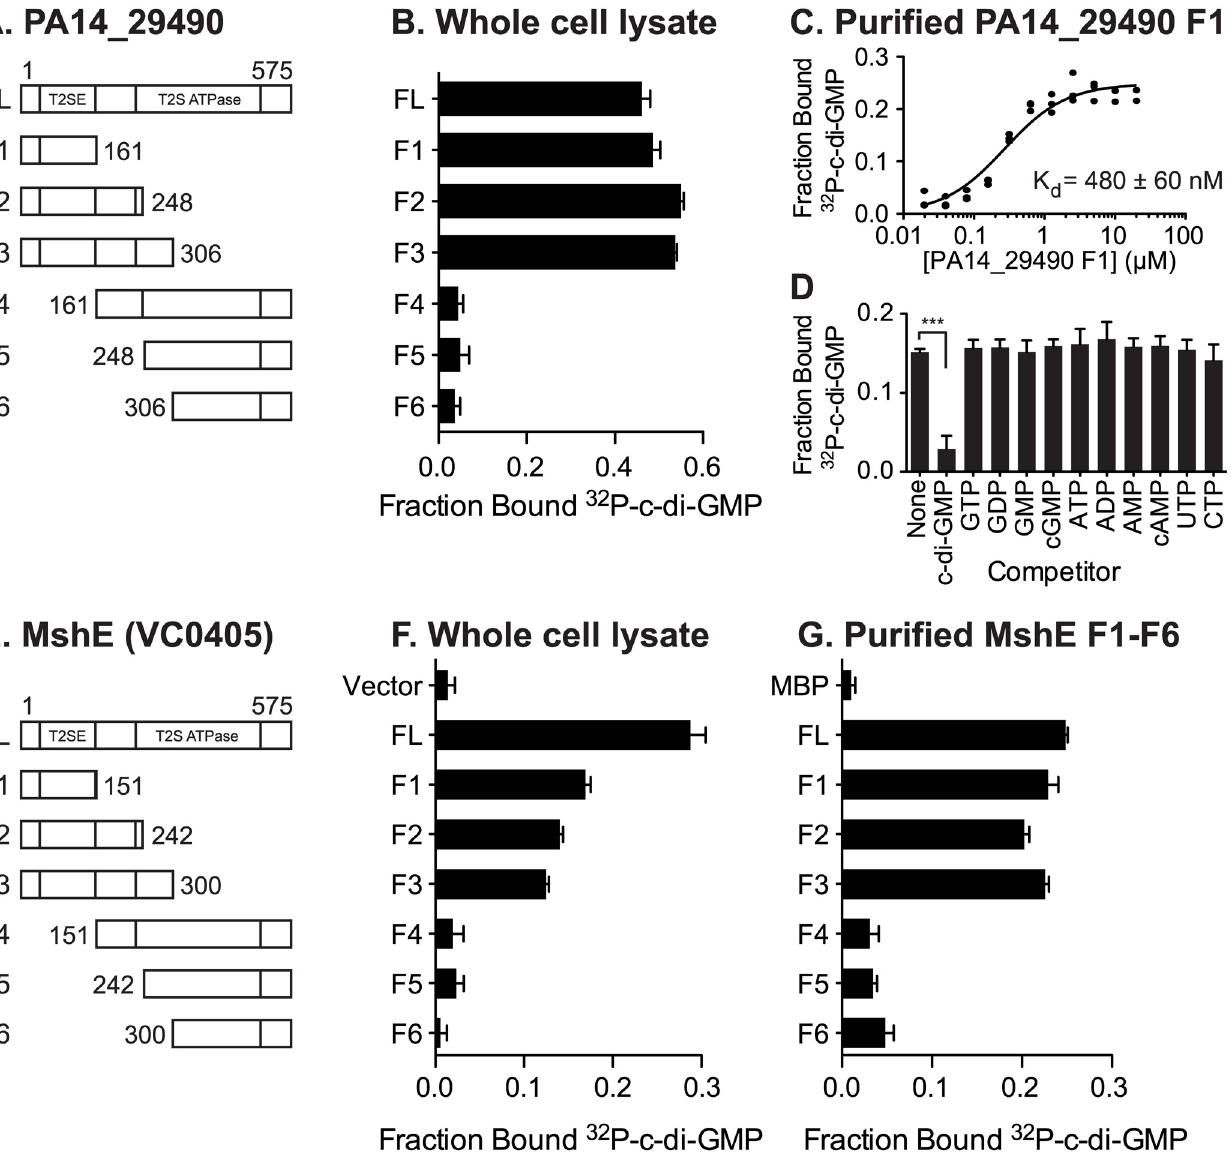
Fig 4. C-di-GMP binds MshE and PA14_29490 in the N-terminal T2SSE_N domain. Schematic of the truncations generated in (A) PA14_29490 and (E) MshE. C-di-GMP binding to E . coli whole cell lysates expressing each fragment of (B) PA14_29490 and (F) MshE. (C) Fraction bound 32 P-c-di-GMP to decreasing concentrations of purified PA14_29490 fragment 1. (D) Fraction bound of purified PA14_29490 fragment 1 to 32 P-c-di-GMP in the presence of 100 μ M nucleotide competitors. (G) Fraction bound of 32 P-c-di-GMP to purified MshE and fragments 1 – 6. Indicated p-value was determined by two-tailed t- test ( *** p (cid:1) 0.001) by comparing the indicated samples. All data are average of three independent assays and standard deviation is indicated by error bars.